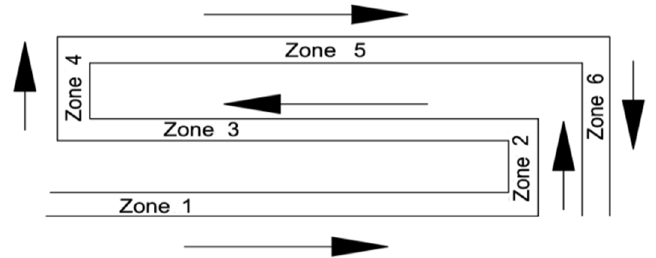
Figure 5. Division of damping channels and flow direction diagram of annular multi-channel MR valve.